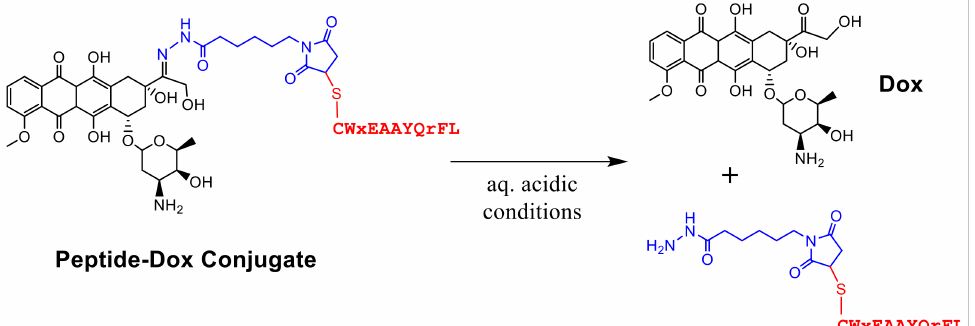
Figure 1. Structure of keratin 1 targeting peptide-Dox conjugate (PDC). The conjugate contains an N -acyl hydrazone linker which hydrolyzes under aqueous acidic conditions to give unmodified doxorubicin (Dox) and hydrazide linker with the peptide. Peptide, linker, and Dox are shown in red, blue, and black,